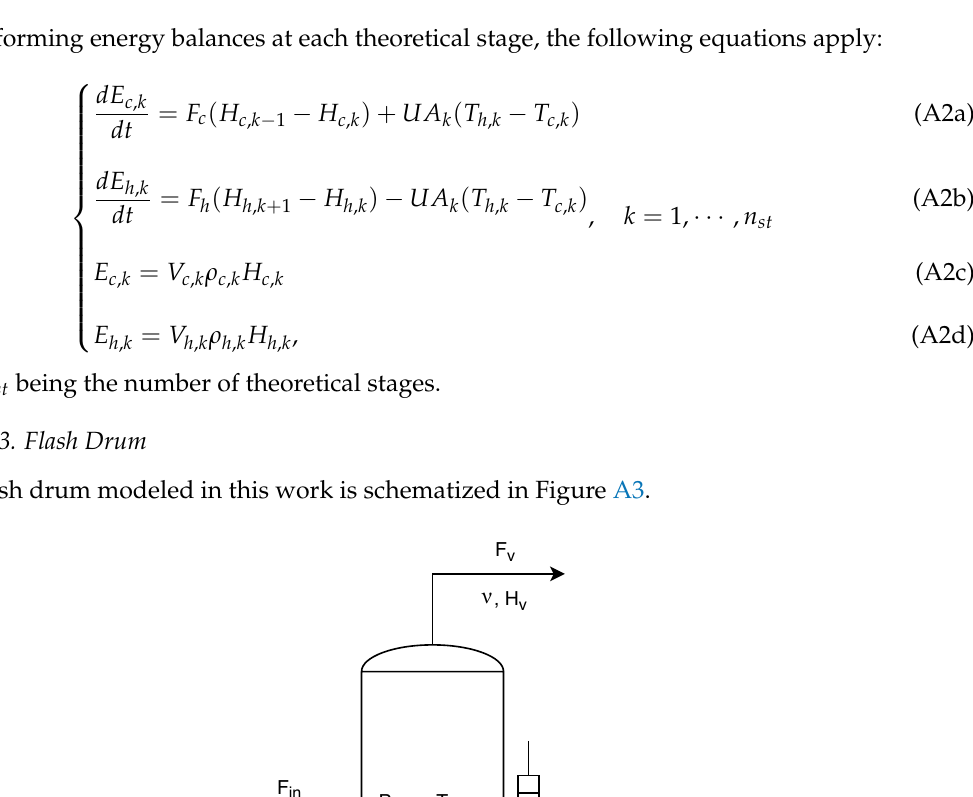
Figure A2. Heat exchanger discretization scheme, emphasizing model variables.